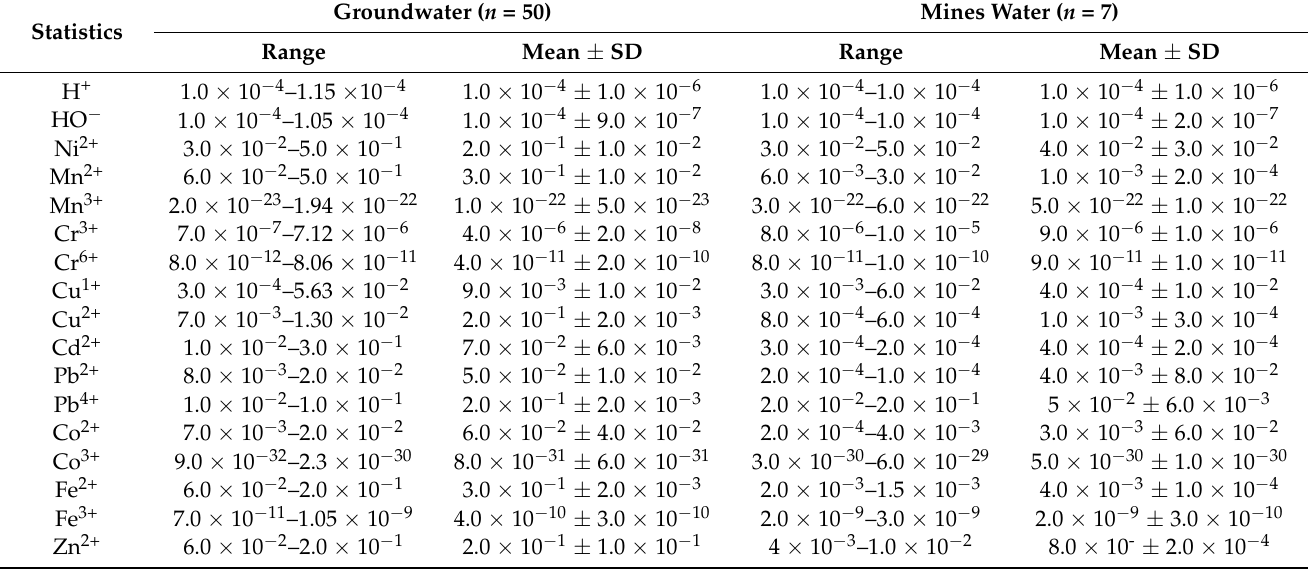
Table 2. Chemical speciation of PHEs in groundwater and mine water in the Adenzai flood plain area,